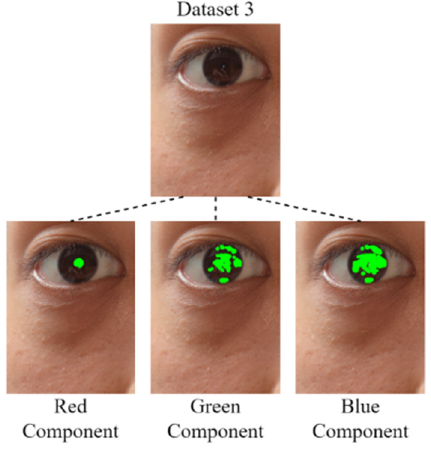
Figure 24. Image from Data Set 3.